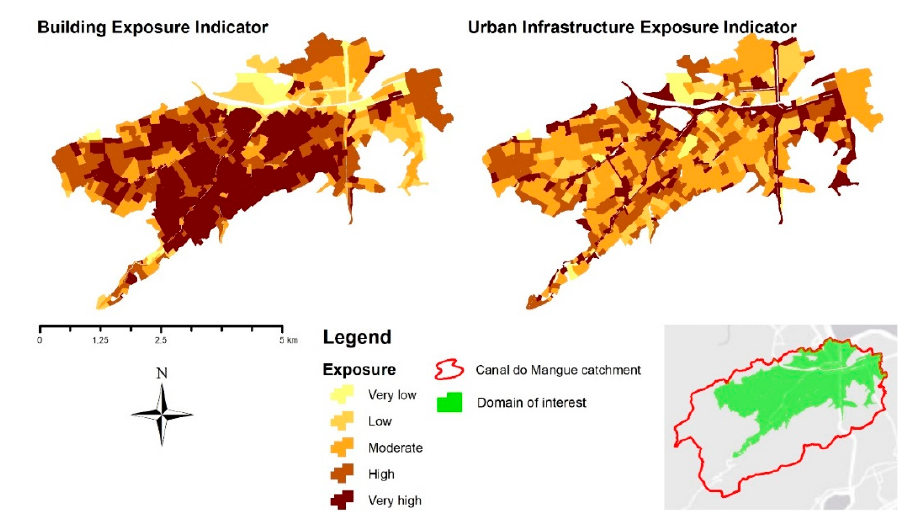
Table 3. Flood risk indicators classes.